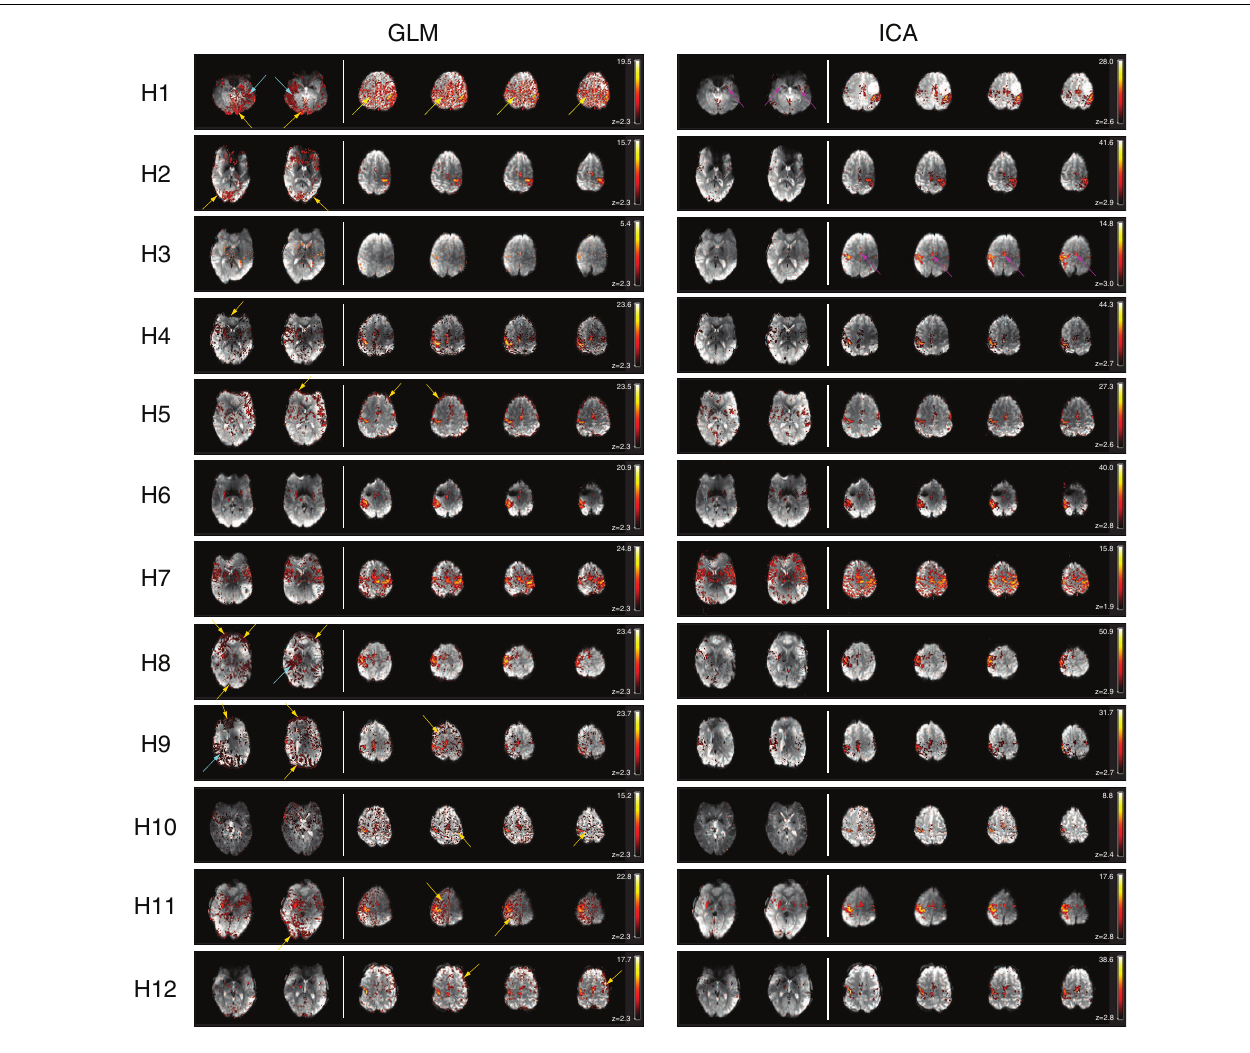
arrows in ICA. Activated areas not present in corresponding GLM results, or not distinguishable from artifacts, are indicated by magenta